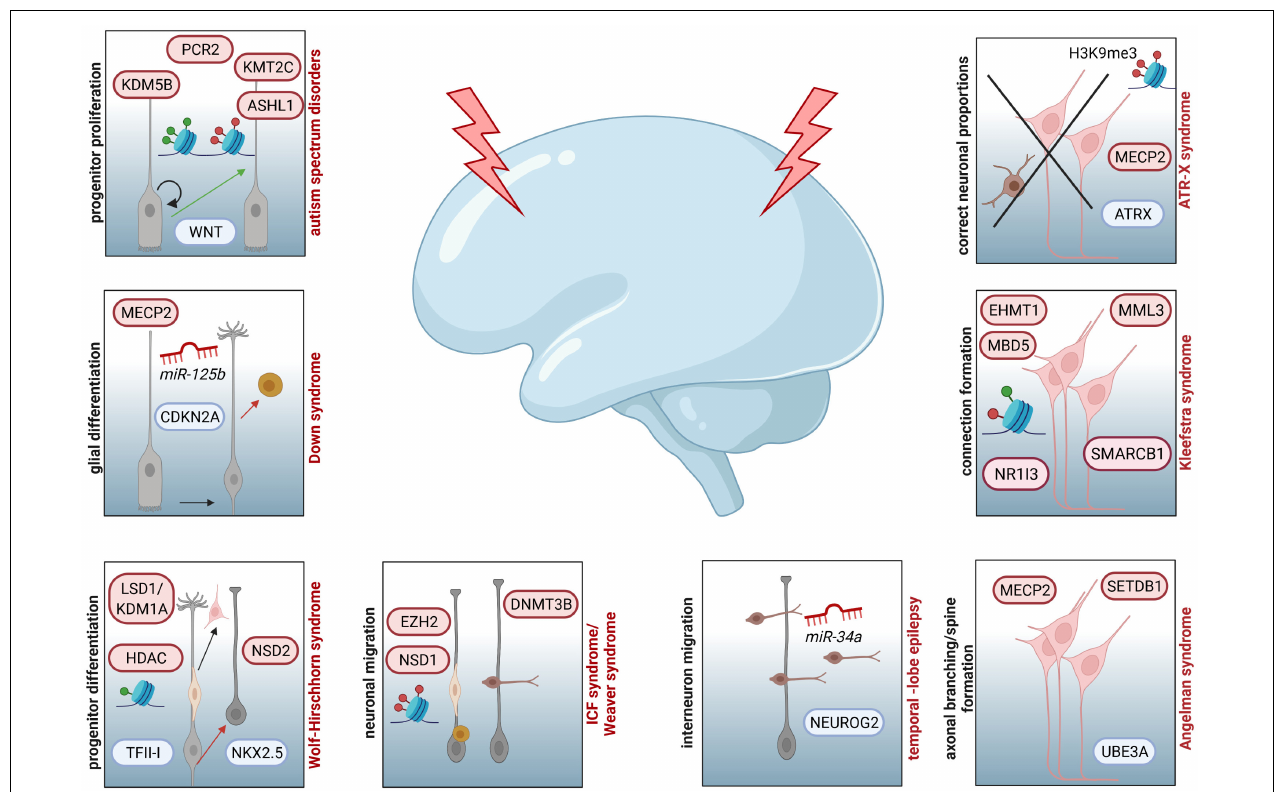
FIGURE 2 | Examples of NDDs involving epigenetic key players and affected processes during corticogenesis assumed to contribute to the respective diseases. Increased progenitor proliferation and decreased neurogenesis due to dysregulated function of WNT can be traced back to aberrant activity of PCR2, KMT2C, KDM5B or ASHL1 in ASD. In individuals affected by Down syndrome, miR125b and MECP2 are associated to altered CDKN2A expression and glial proliferation. For patients with Wolf-Hirschhorn syndrome neuronal progenitor proliferation is disturbed by aberrant activity of LSD1/KDM1A and HDAC, both targeting the transcription factor TFII-I, as well as dysregulated function of NSD2, which is influencing the expression of NKX2.5 . In case of ICF syndrome, associated mutations in DNMT3B are resulting in hypomethylated genes essential for neuronal migration ( LHX2, ROBO1, CXCR4, IFRD2, DTX4, ENC1, JARID2, SEMA3B , and ITM2 ). Additionally, patients with Weaver syndrome are characterized by neuronal migration defects, due to haploinsufficiency of EZH2 , disturbing PRC2 activity, and mutations in NSD1 , impairing proper establishment of histone marks. At the level of interneuron migration, different miRNAs are regulating this pivotal step of corticogenesis. For example, downregulation of miR-34a is affecting NEUROG2 expression, which is essential for neuronal migration. Mutations in UBE3A and dysregulated expression of MECP2 and SETDB1 are linked to susceptibility of Angelman syndrome, which is also characterized by deficits in axonal branching, spine formation and synapse generation. In individuals with Kleefstra syndrome, dysregulated interhemispheric connections are reported as potential result of mutations in EHMT1 , leading to disturbed interaction with EHMT2 or EZH2 and changes in expression of genes coding for epigenetic regulators, such as MML3, SMARCB1, NR1I3 , or MBD5 . Deficits in ATRX-MECP2 interaction, subsequent aberrations in H3K9me3 marks and resulting improper neuronal proportions in different cortical and subcortical areas are depicted for ATR-X